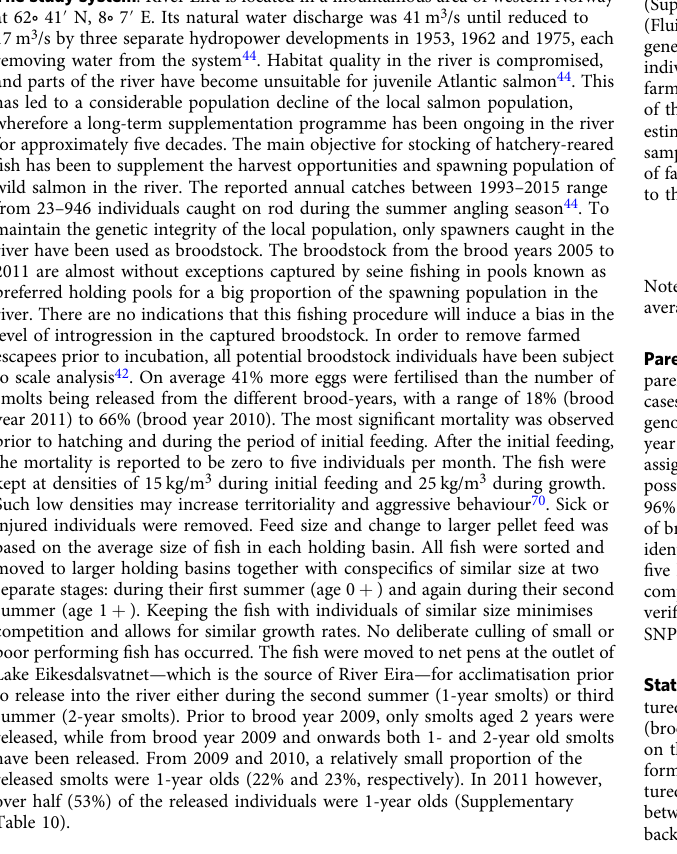
(Supplementary Table 11) using the EP1TM 96.96 Dynamic array IFCs platform (Fluidigm). Out of the nuclear SNPs, 48 have been identi fi ed as showing large genetic differences between farmed and wild salmon 46 and were used to estimate individual introgression following a STRUCTURE based method 2 . Proportion of farmed ancestry ( D ) in each individual was determined from individual estimates of the probability of belonging to farmed salmon ( P ind ) by scaling to the average estimates of probability of belonging to farmed salmon in a historical reference sample of pure wild salmon from the Eira ( P W = 0.0644) and to reference samples of farmed salmon from all breeding lines used in Norway ( P D = 0.903), according to the following formulae 2